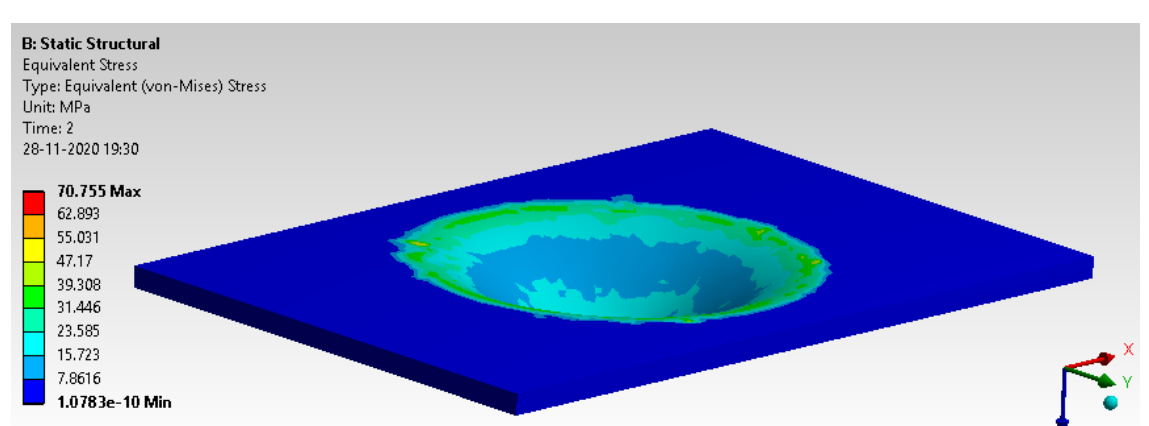
Figure 19. The von Mises stress.